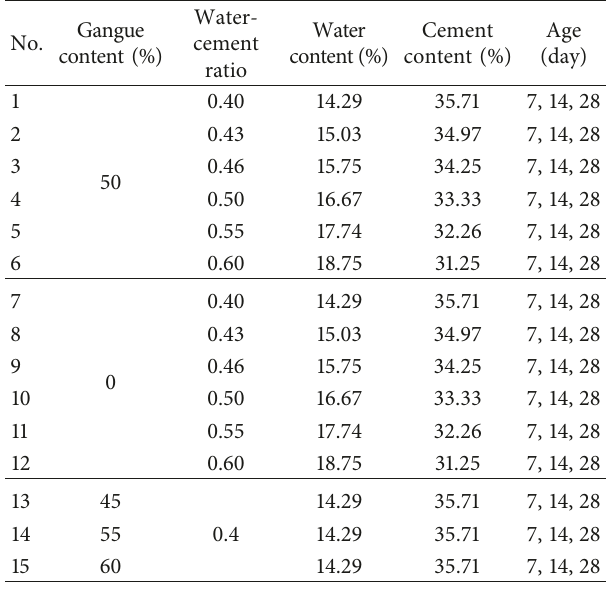
Table 2: Sample gangue concrete ratios (mass ratios).